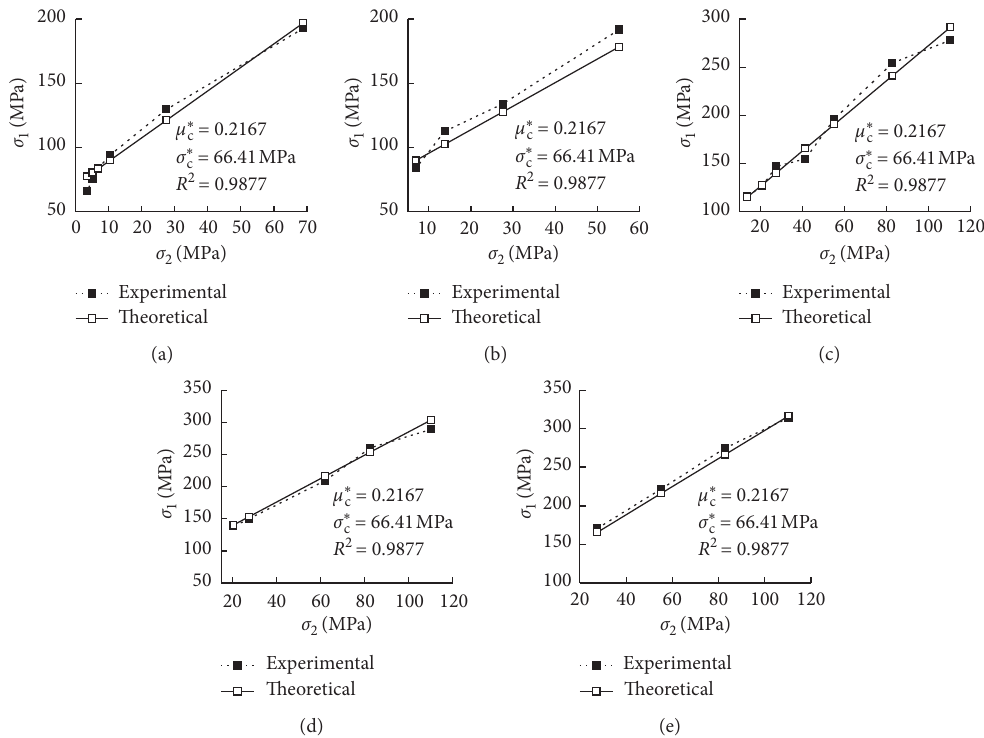
Figure 10: True triaxial tests data and theoretical results of coarse-grained dense marble [36]. (a) σ (c) σ 3 � 13.79MPa. (d) σ 3 � 20.68MPa. (e) σ 3 �